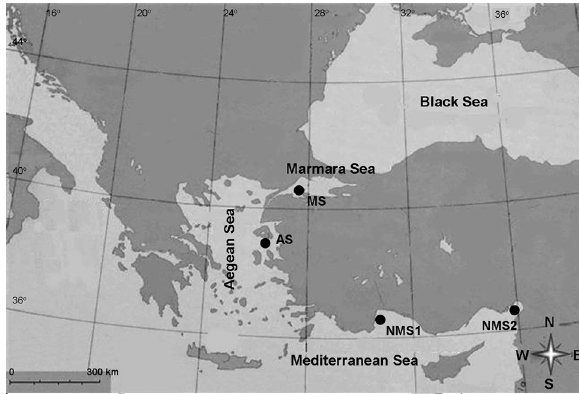
Fig. 1. – map of the sampling locations for the common cuttlefish.  indicates sampling location; mS, marmara Sea; aS, aegean Sea; nmS1, north-eastern mediterranean Sea (antalya Bay); nmS2, north-eastern mediterranean Sea (iskenderun